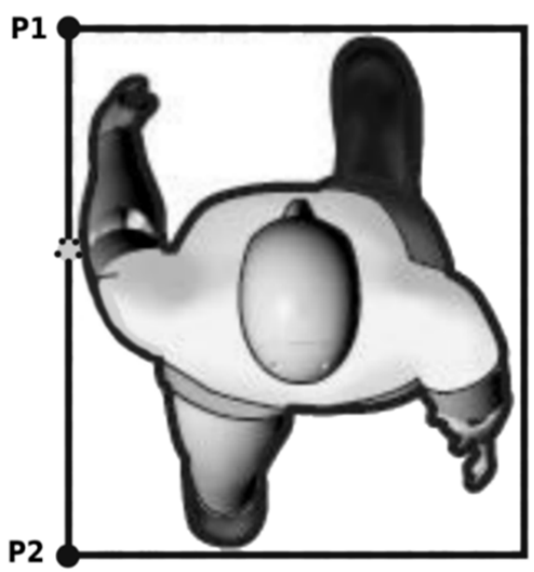
Figure 9. Vehicle schematization.